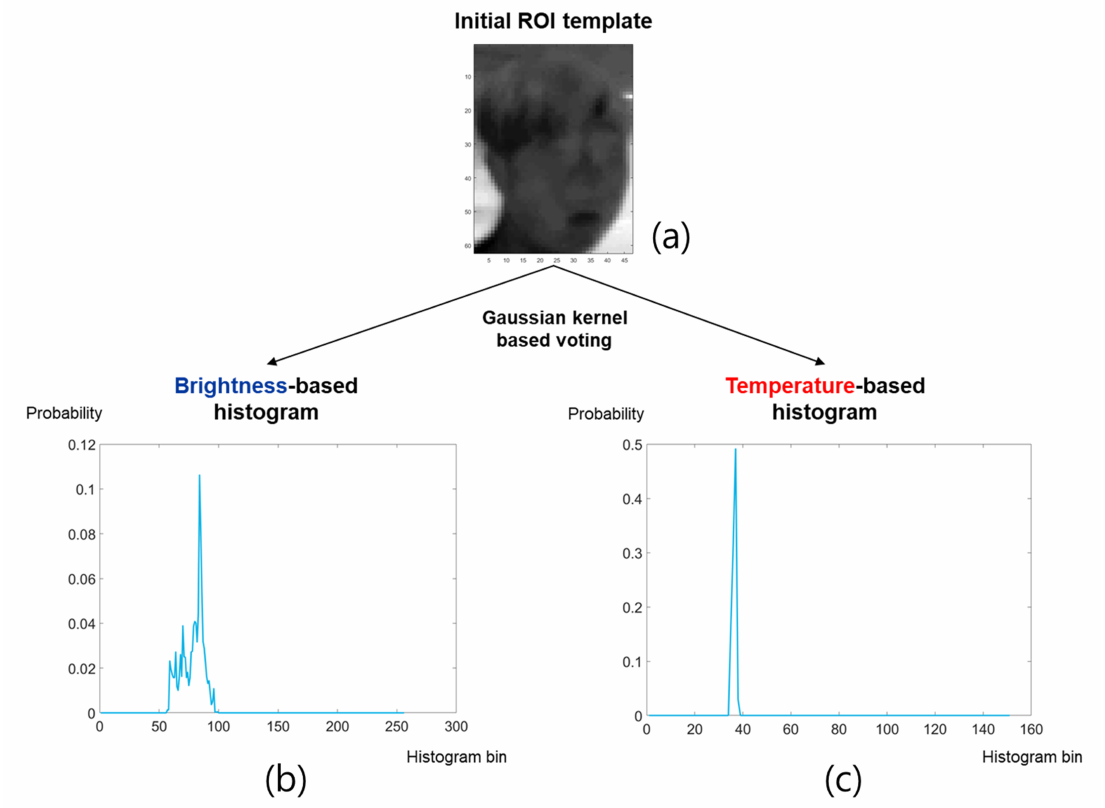
Figure 5. Comparison brightness histogram and temperature histogram: ( a ) target Region of Interest (ROI) template, ( b ) brightness-based histogram, ( c ) temperature-based